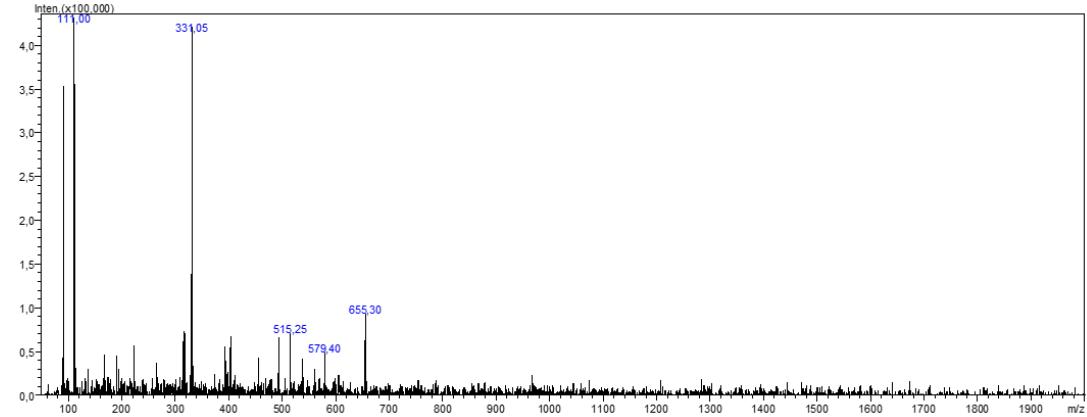
Figure 2. Mass spectra of the TFE sub-extract. Table 5. Mass spectral characteristics and the identity of the compounds in the TFE sub-extract. [M-H] - ( m / z ) Compounds